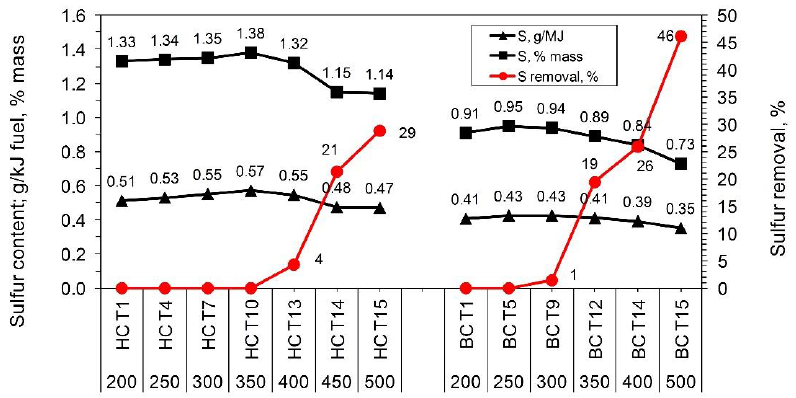
Figure 3. The average sulfur content and degree of sulfur removal vs. process temperature for hard coals (HC1, HC2, HC3) and lignite (BC1, BC2).